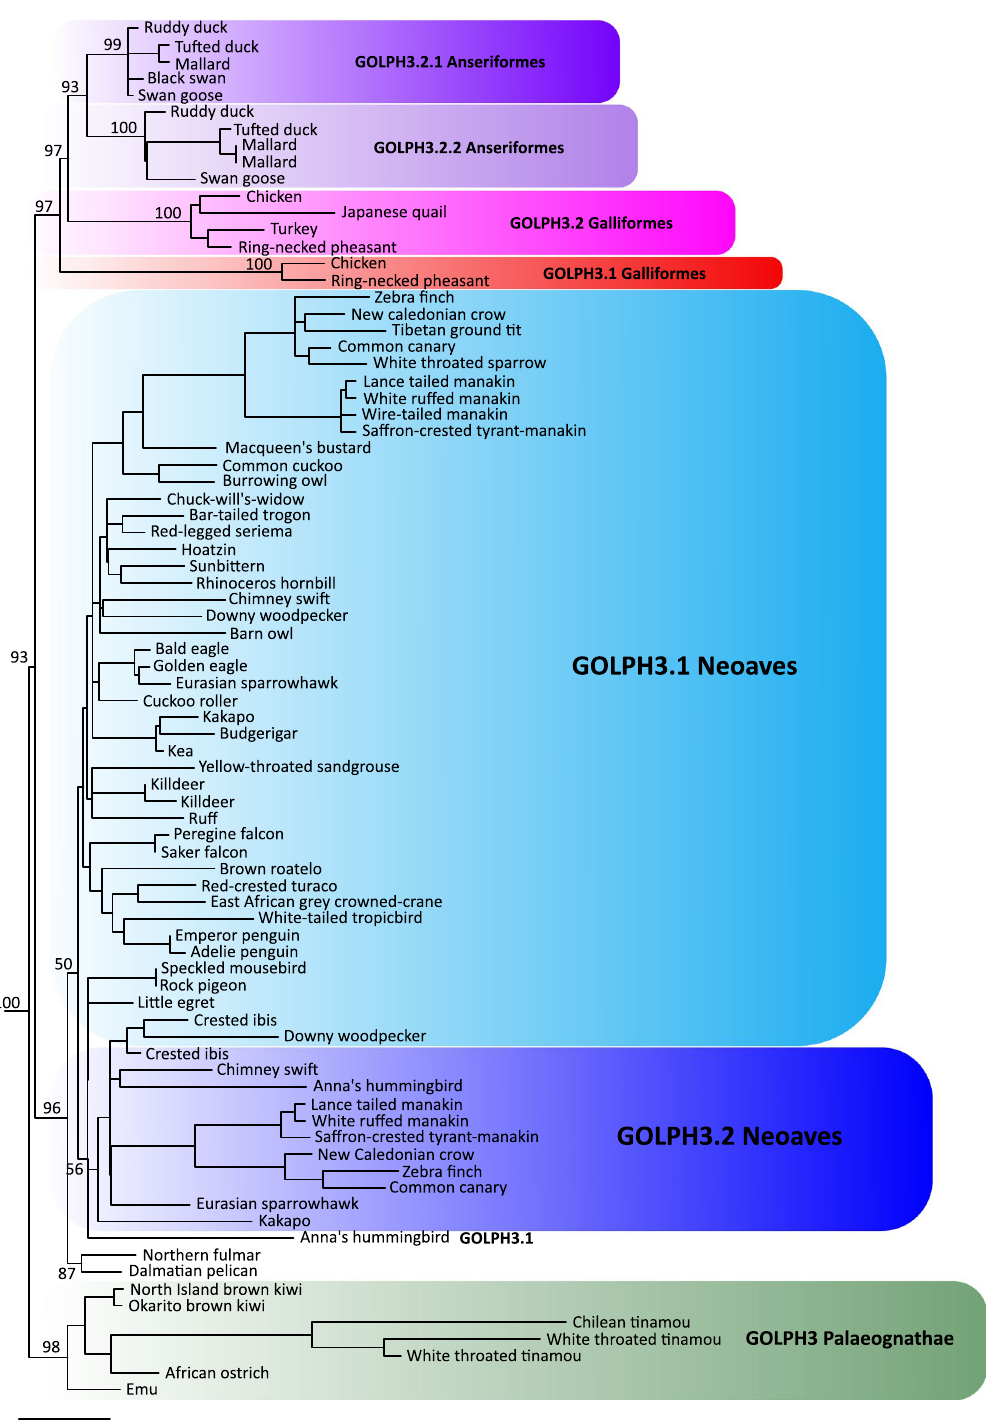
Figure 1. Maximum likelihood tree showing sister group relationships among GOLPH3 genes of birds. Numbers above the nodes correspond to support values from the ultrafast bootstrap routine. GOLPH3 sequences from crocodiles and turtles were used as outgroups (not shown). The scale denotes substitutions per site and colors represent gene lineages. In the case of the Northern fulmar and Dalmatian pelican, there is no syntenic information to define to which gene lineage they belong. In consequence, they were not included in any shading or do not have a gene